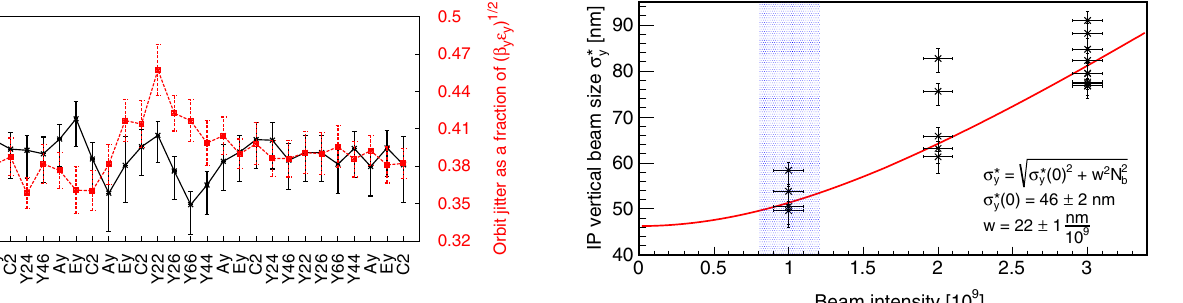
TABLE III. Measured IP vertical beam size after the tuning